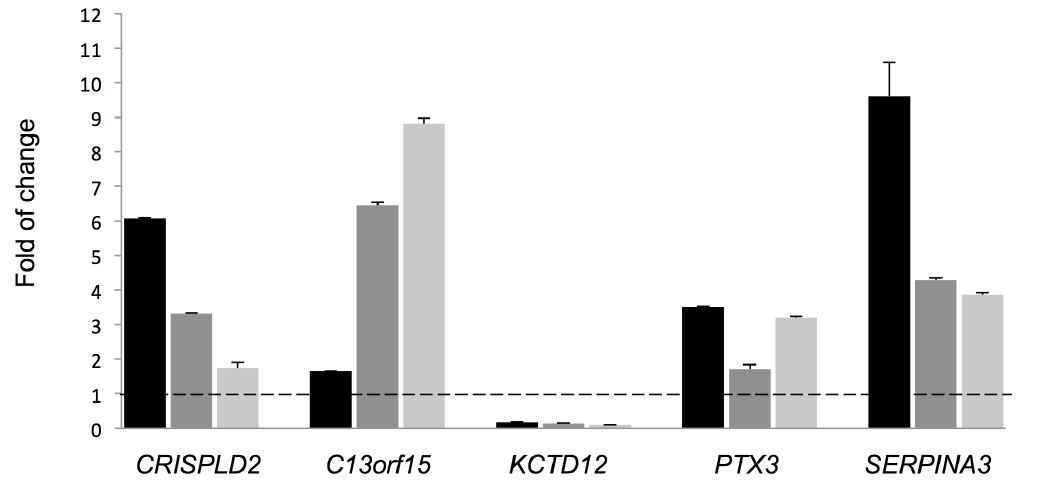
Figure 2. Validation of GC responsive genes. After cells from three individual ASM lines were treated with 1 m M DEX for 18 h, the mRNA levels of indicated genes were measured by qRT-PCR and the folds of change induced by DEX were calculated. Each column bar represents an individual cell line; experiments for each cell line were performed in triplicate. Error bars are SE values corresponding to a cell line’s replicates. doi:10.1371/journal.pone.0099625.g002 PLOS ONE |